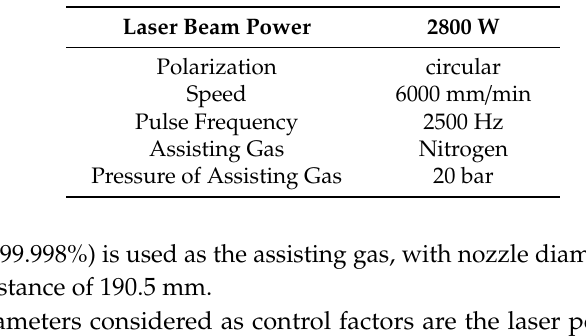
Table 2. Bystronic laser, (2000), BYSTAR specification.